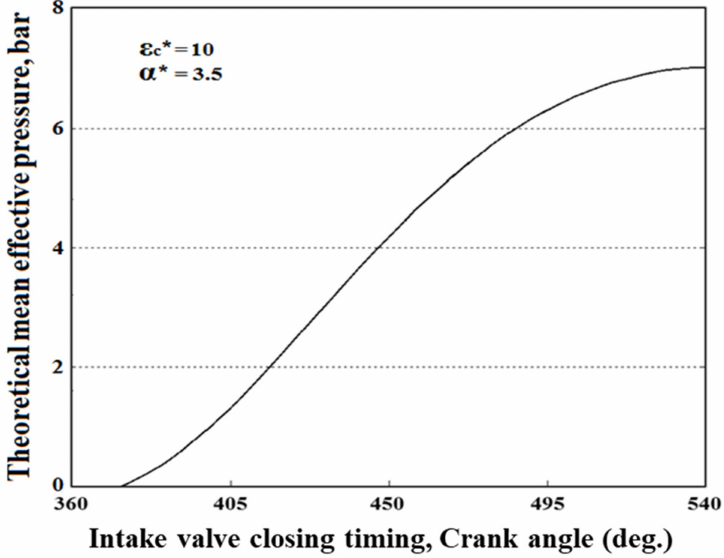
Figure 4. Theoretical MEP of Otto-Miller cycle according to the intake valve closing